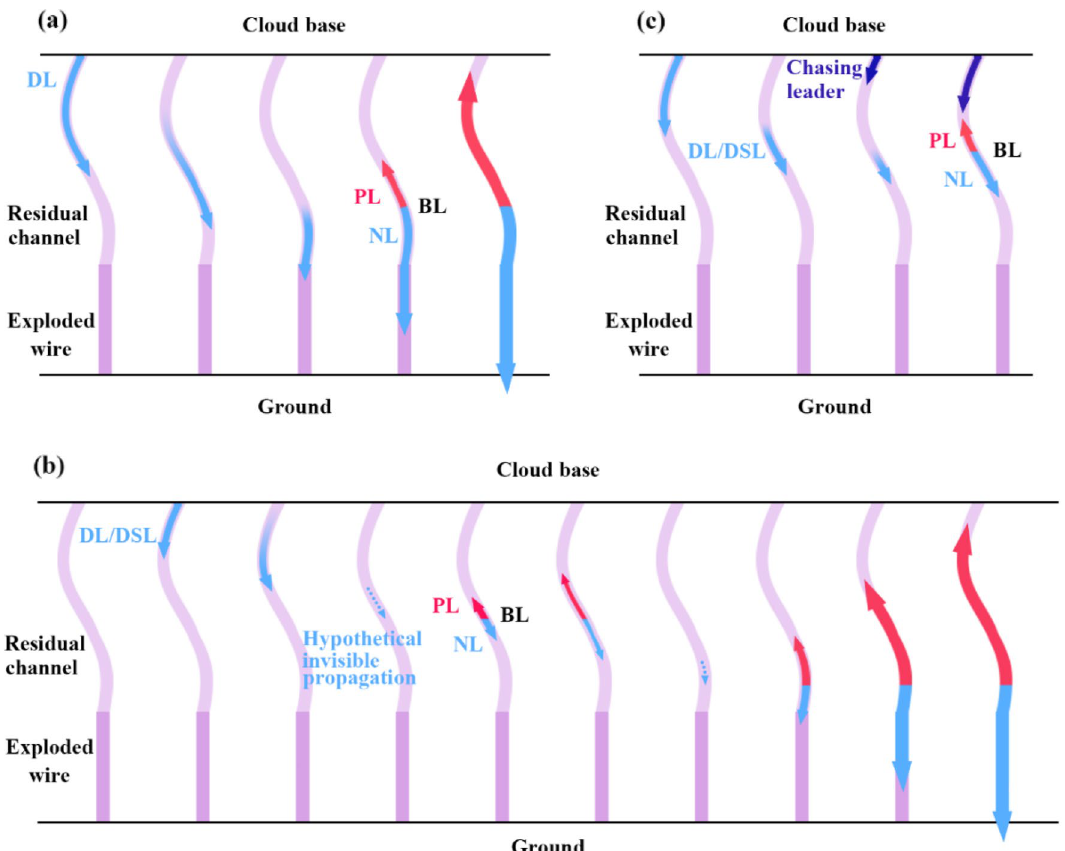
Figure 8. Concept maps of three types of bidirectional leader development. ( a ) A reflection type. ( b ) A discontinuity type. ( c ) An inducement type. DL dart leader, PL positive leader, NL negative leader, BL bidirectional leader, DSL dart-stepped